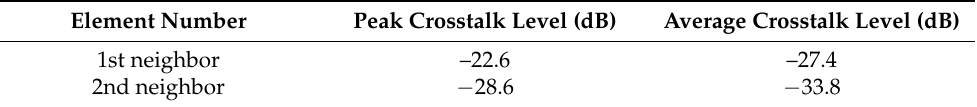
Table 5. Crosstalk levels of the aerogel coated CMUT array